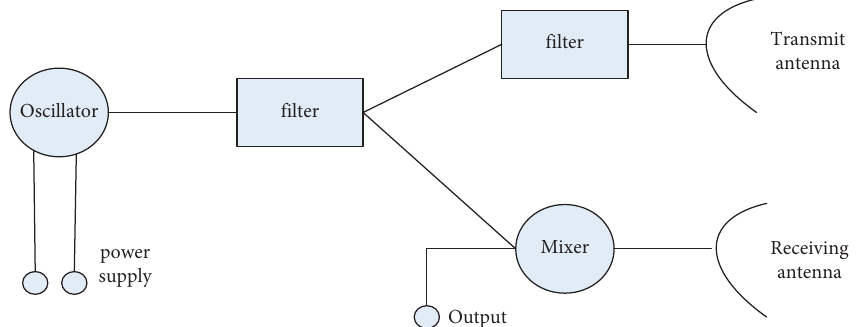
Figure 2: Block diagram of continuous wave radar.